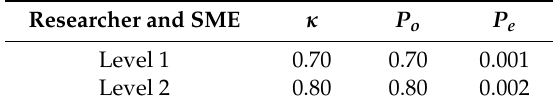
Table 5. Derived agreement statistics in all levels for researcher and AIB SME.